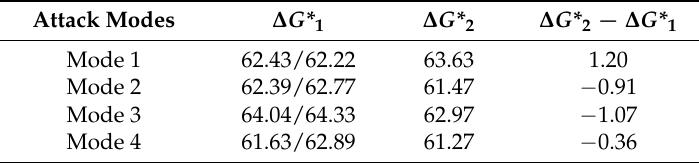
Table 1. Free energy barriers for the direct nucleophilic substitution of TCDD by H 2 O 2 in different attack modes a .